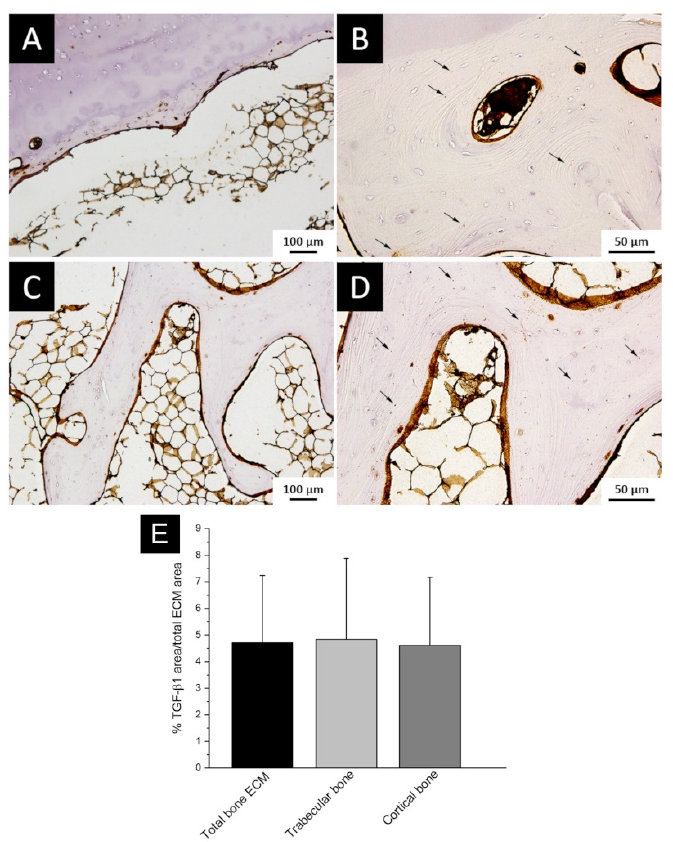
Figure 3. TGF- β 1 staining in bone tissue and semi-quantitative analysis ( A – D ): TGF- β 1 staining in cortical ( A , B ) and trabecular ( C , D ) bone tissue. (( A , C ) 10 × magnification; ( B , D ) 20 × magnification); black arrows highlight the protein accumulation in bone ECM. ( E ) Histogram representing area percentage of TGF- β 1 staining.